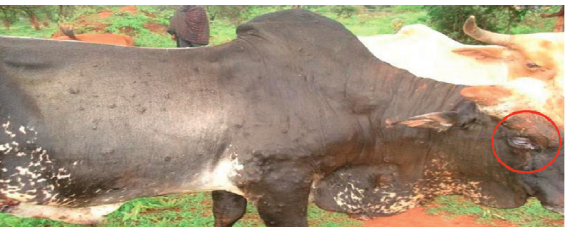
Figure 2: An inflammation and whiteness of the eye of cattle infected with LSD. Encircled area shows lacrimation probably because of secondary bacterial complication.